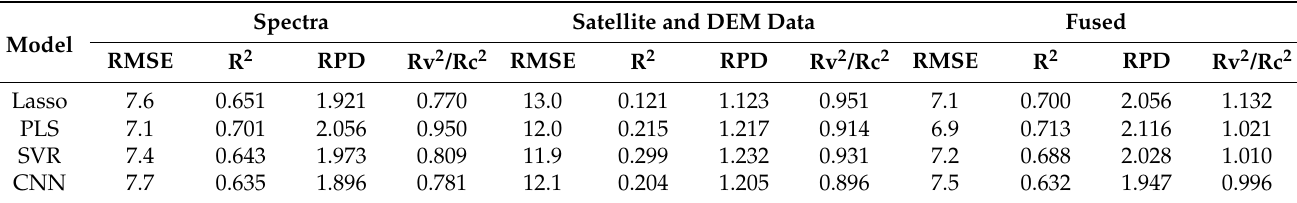
Table 4. Performance of SOM prediction by different models and data.